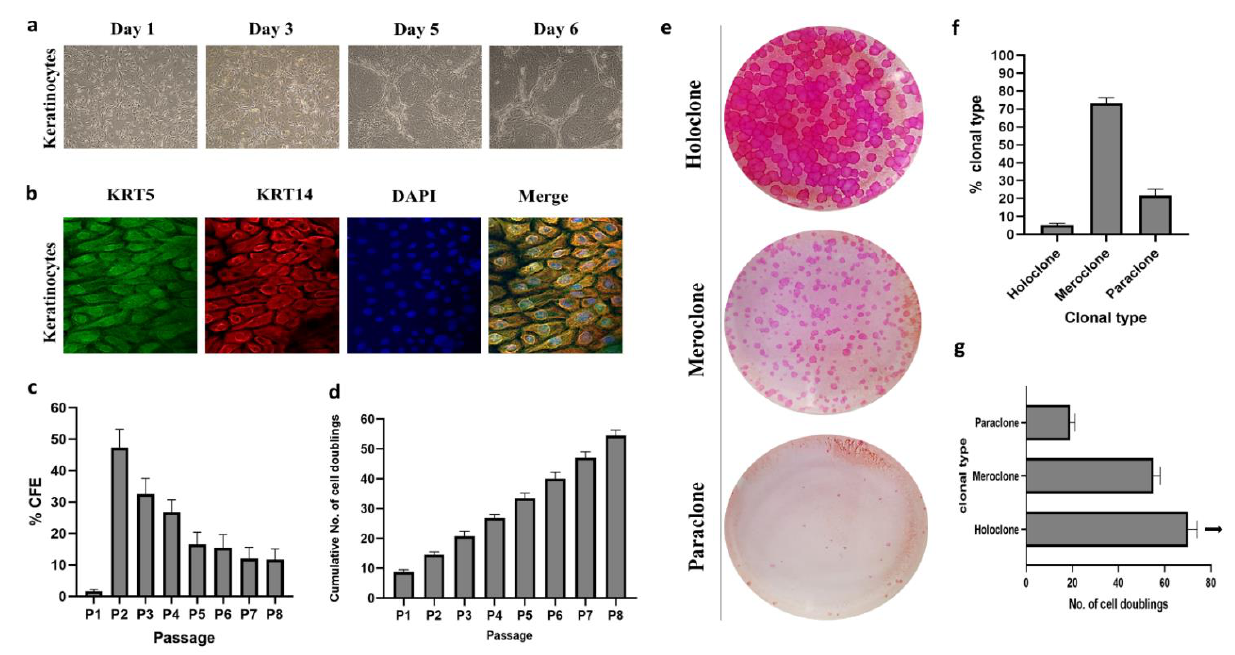
Figure 1. Characterization of human keratinocytes derived from foreskin. ( a ) Phase-contrast microscopic analysis for cell morphology of keratinocytes (P2) at different time points (40X). ( b ) Confocal images representing immunofluorescence shows the expression of epidermal markers KRT5 (green) and KRT14 (red), with the nucleus also stained blue using DAPI (100X). ( c ) The percentage of CFE and ( d ) cumulative number of cells doubling in each passage, which are representative of 6 samples, expressed as mean ± SD. ( e ) Clonal analysis and classification of clonal types; classification was based on the percentage of aborted colonies (<3 mm 2 in diameter); when 0–5% of colonies were aborted the clone was scored as holoclone. When more than 95% of the colonies were aborted, the clone was classified as paraclone. When more than 5%, but less than 95% of the colonies were aborted, the clone was classified as meroclone. ( f ) Average percentage of holoclones, meroclones, and paraclones ( Y -axis) were identified by clonal analysis of 6 donor samples. ( g ) The number of cell doublings performed by cultured cells, which were calculated using the following formula: x = 3.322 log N/N o , where N equals the total number of cells obtained at each passage and N o equals the number of clonogenic cells plated. The arrows indicate cells that continued to divide after passage 8.